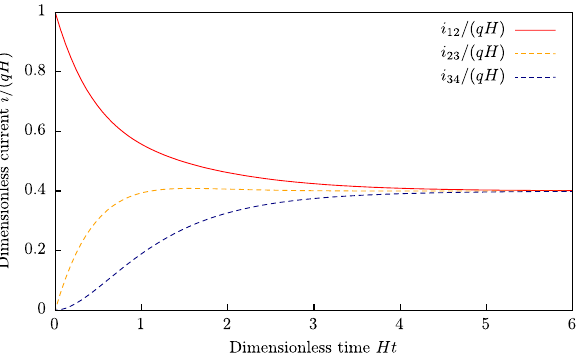
Figure 3. Evolution of currents between traps i 12 , i 23 and i 34 for a uniform chain of four traps under strong electric